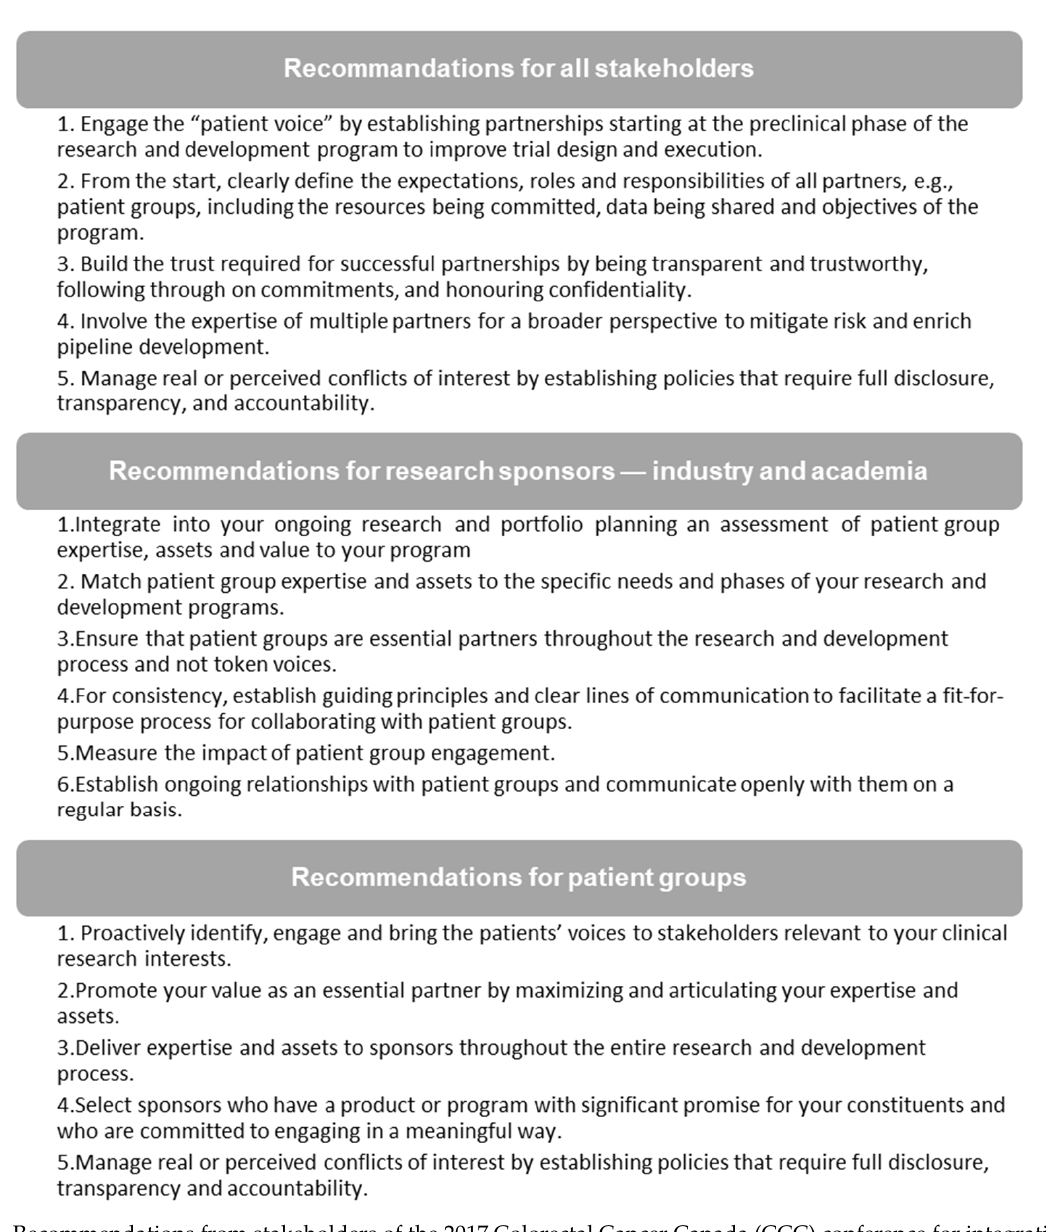
Figure 2. Recommendations from stakeholders of the 2017 Colorectal Cancer Canada (CCC) conference for integrating PGs in cancer CTs, used in the drafting process of the Charter.